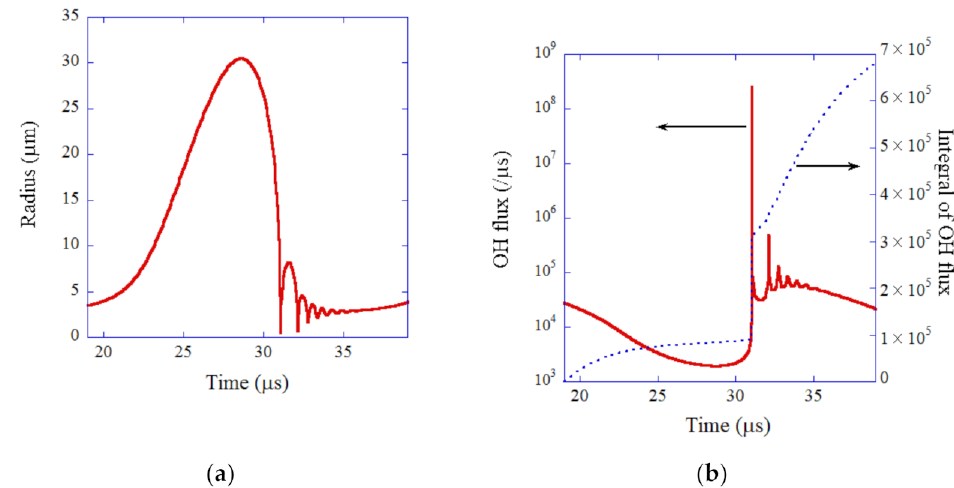
Figure 2. The results of the numerical simulation under the experimental condition of single-bubble sonochemistry as a function of time for one acoustic cycle [40]. The frequency and pressure amplitude of ultrasound are 52 kHz and 1.52 bar, respectively. ( a ) The bubble radius. ( b ) The dissolution rate of OH radicals into the liquid from the interior of the bubble (red solid line) and its time integral (blue dotted line). Copyright 2005, with permission of AIP